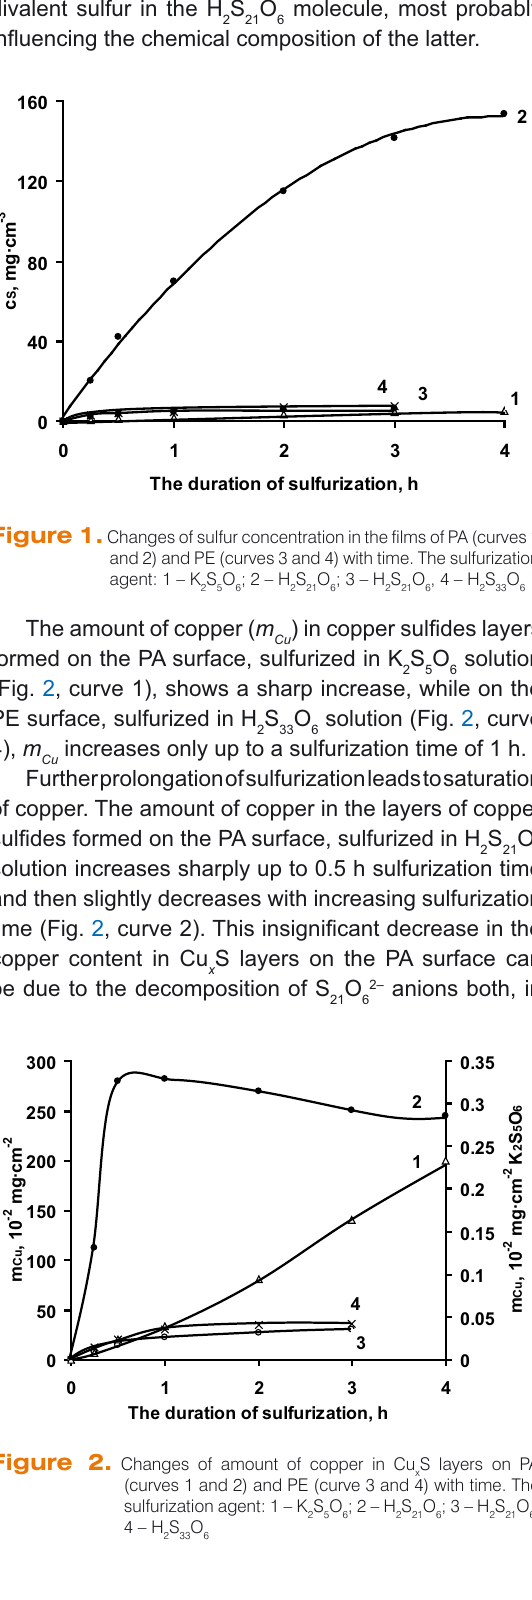
Table 1. Sheet resistance (R) of Cu